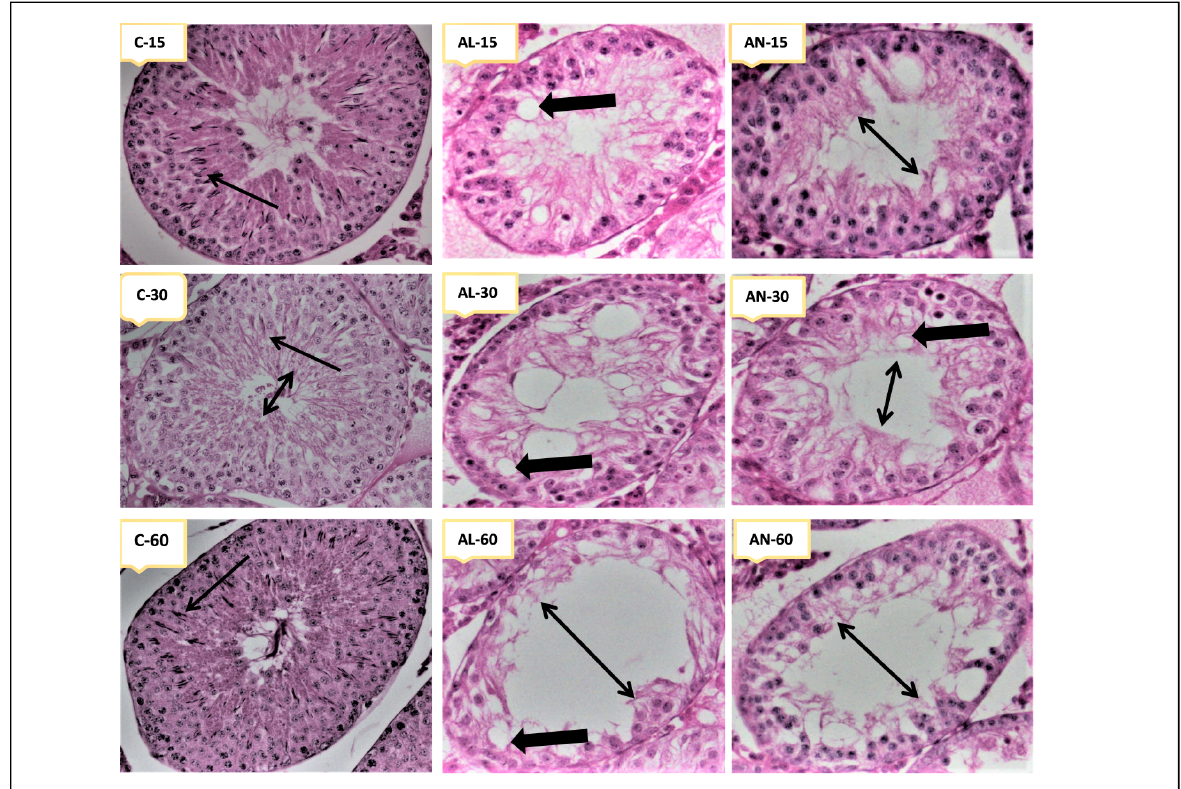
Figure 5b: Histopathology of the M. natalensis rat’s testes at x 400 Note: Upper row (15 days treated) groups: C = control groups: normal seminiferous tubule (ST) with intact germinal epithelium, adlumen, and lumen (Single black arrows). AL= A. lebbeck stem bark methanolic extract treated group: a mixture of normal ST and ST with damages in germinal epithelium, adlumen and widened lumen (Double black arrows), intraepithelial vacuolation (Thick black arrow). A. nilotica pods methanolic extract treated group: a mixture of normal ST and ST with damaged germinal epithelium, adlumen and widened lumen (Double black arrows), intraepithelial vacuolation (Thick black arrow). Middle row (30 days treated) and lower row (60 days treated) groups: C = control groups: normal seminiferous tubule (ST) with intact germinal epithelium, adlumen, and lumen (Single black arrows). A. lebbeck stem bark methanolic extract treated group: ST with exfoliated germinal epithelium, damaged adlumen and widened lumen (Double black arrows), intraepithelial vacuolation (Thick black arrow). AN = A. nilotica pods methanolic extract treated group: exfoliated germinal epithelium disrupted adlumen and widened lumen (Double black arrows) and intraepithelial vacuolation (Thick black arrow) of